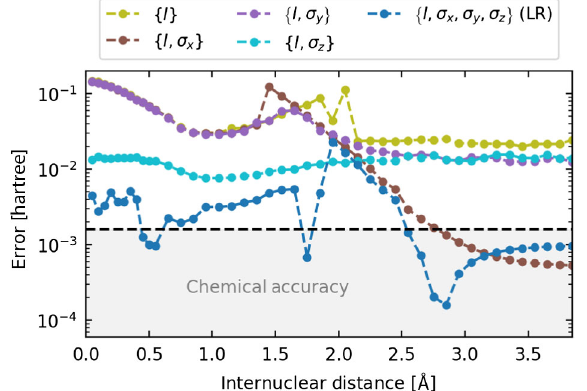
FIG. 4. Comparison of errors in the ground-state energy estimate when applying the QSE protocol using various combi- nations of expansion operators. The linear response expansion (dark blue dots) provides an improvement of more than an order of magnitude over the bare VQE estimate (yellow dots) for the majority of internuclear distances